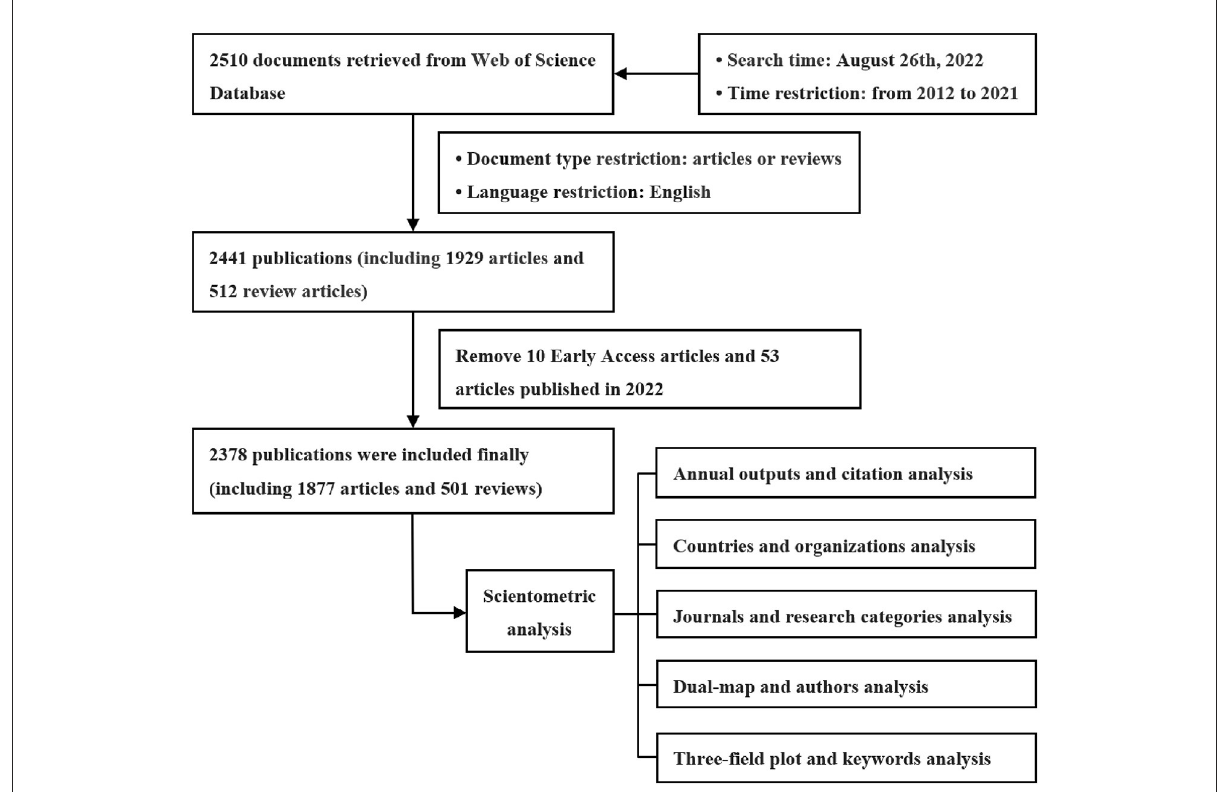
FIGURE1 Flowchart of literature collection and analysis.